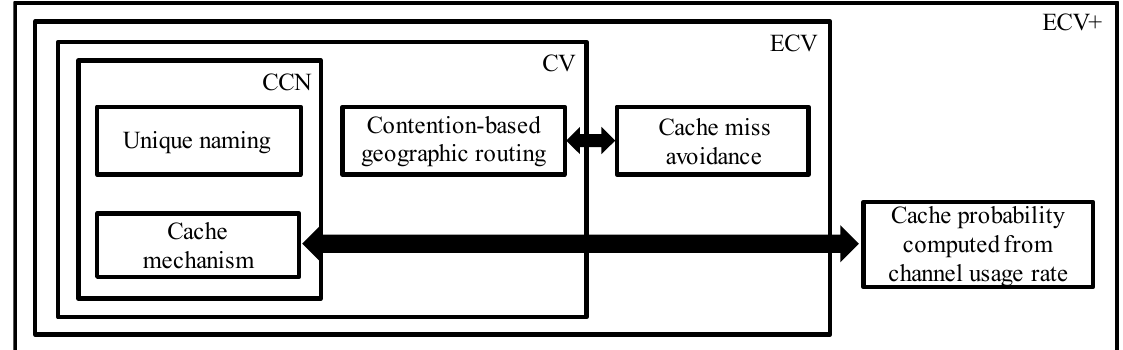
Figure 1. Proposed framework for applying CCN in IVC.